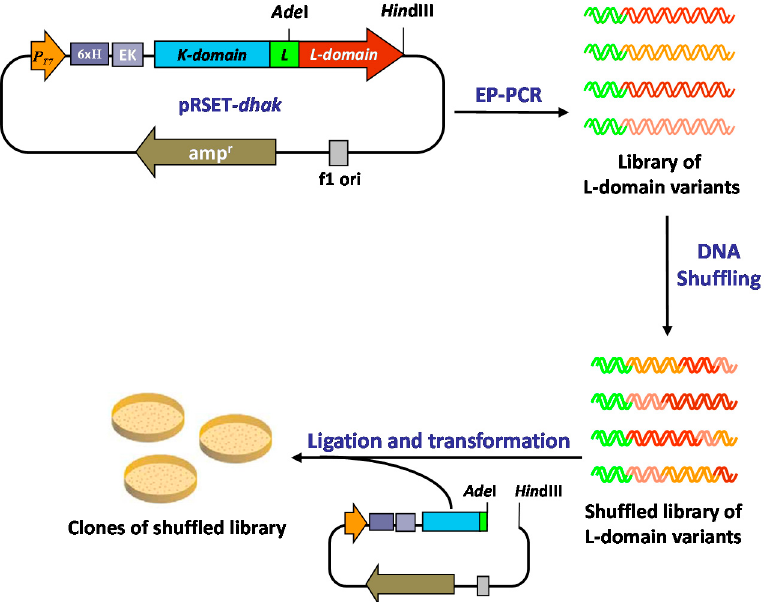
Figure 3. Directed evolution approach applied to modify the phosphoryl donor specificity of the DHAK from C. freundii .